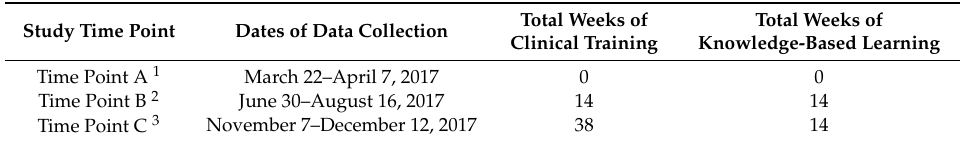
Table 2. The data collection characteristics.